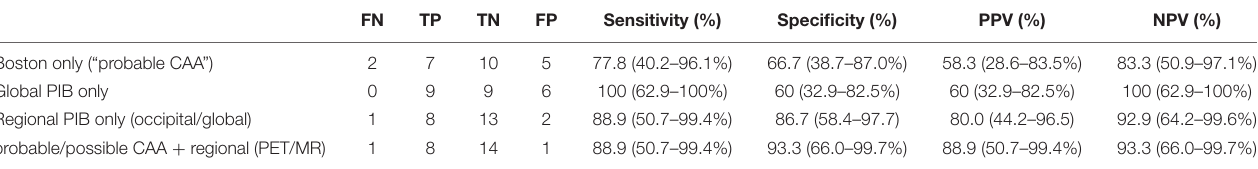
TABLE 3 | The sensitivity, specificity, and positive and negative predictive values of different diagnostic methods for differentiating CAA and